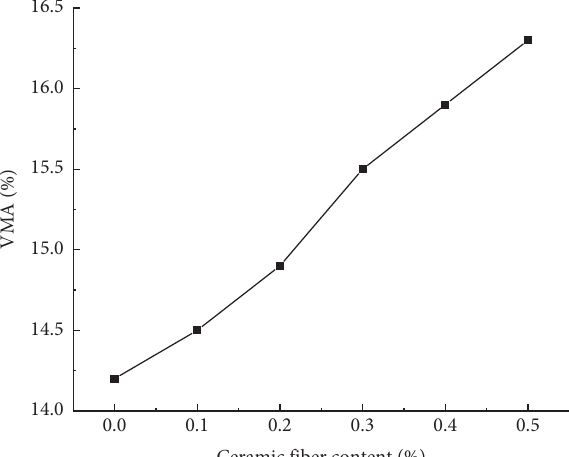
Figure 6: Relation between VMA and CF content.